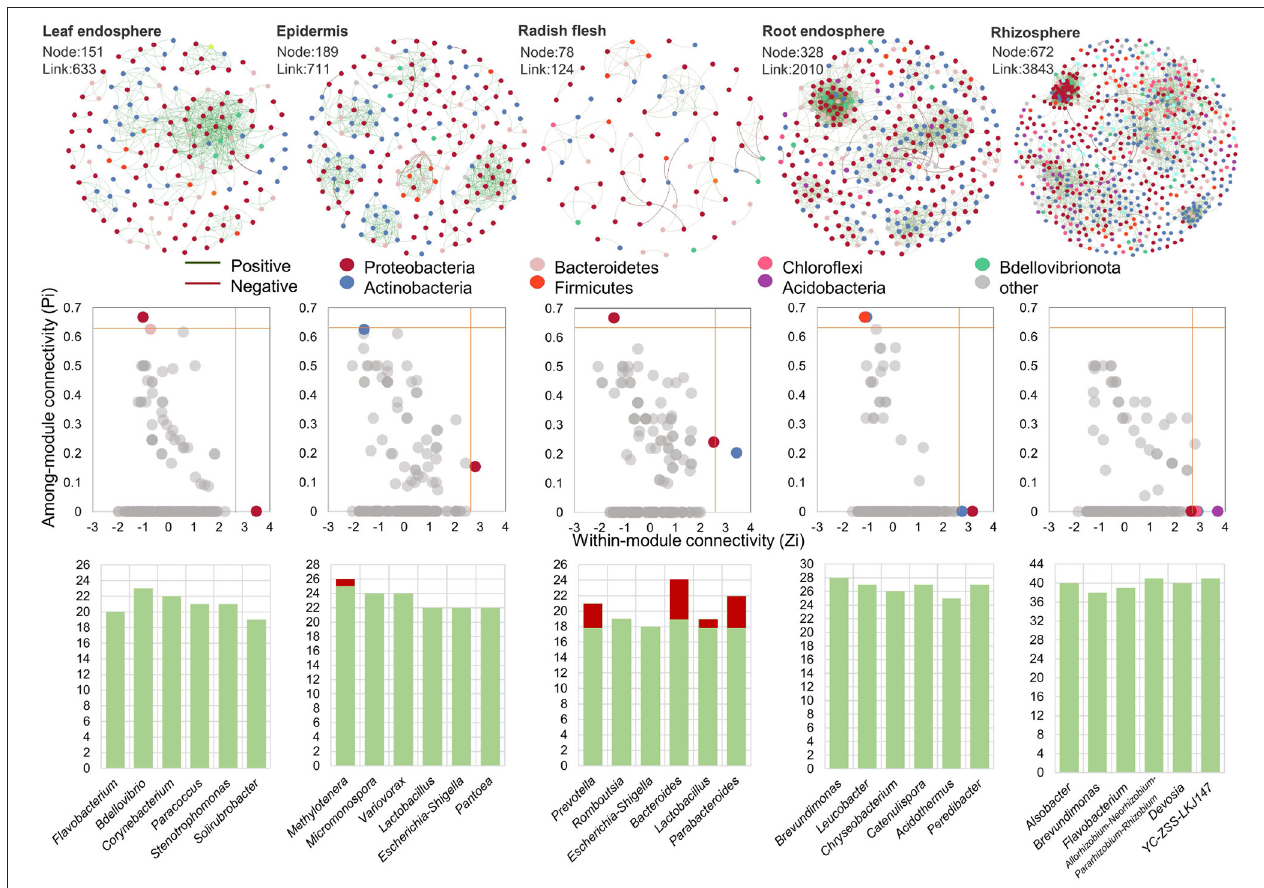
FIGURE 5 | Microbial co-occurrence network diagram in leaf endosphere, radish epidermis, radish flesh, root endosphere, and rhizosphere soil. The distribution of central nodes in leaf endosphere, radish epidermis, radish flesh, root endosphere, and rhizosphere soil. The edge interaction type of genus with connectivity in the top six in different